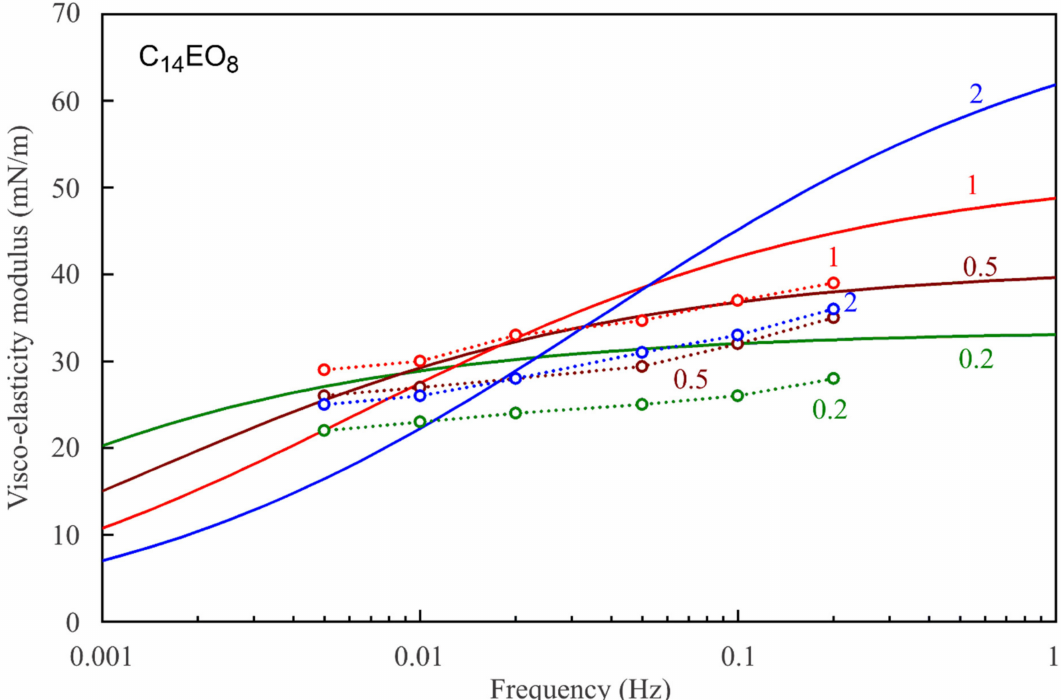
Figure 12. Experimental visco-elasticity modulus vs. frequency for C 14 EO 8 solutions of different concentrations (0.2, 0.5, 1.0, and 2.0 µ mol/L, as indicated by numbers) and the respective theoretical curves calculated with the LvT equation, Equation (8), with E 0 (c) and ω D (c) calculated by using the reorientation model, Equations (1)–(6), with the parameter values presented in Table 1. Dotted lines are guides for the